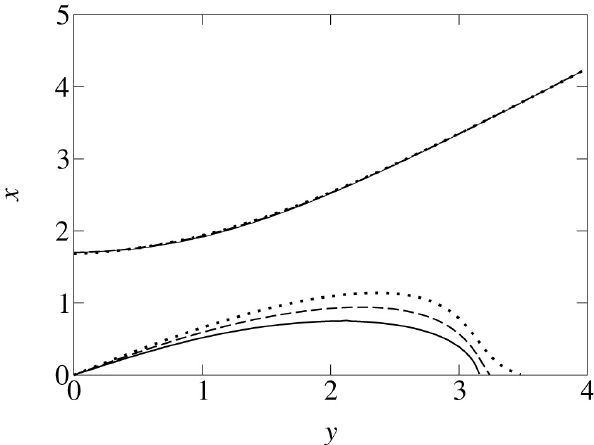
Fig. 4. Solutions of the dispersion relation Eq. (21) for f = 1, α = 0 . 1, v A 0 = 1 (see Eq. (31) below), and three values of β : β = 0 (solid line), β = 0 . 1 (dashed line), β = 0 . 2 (dotted line).